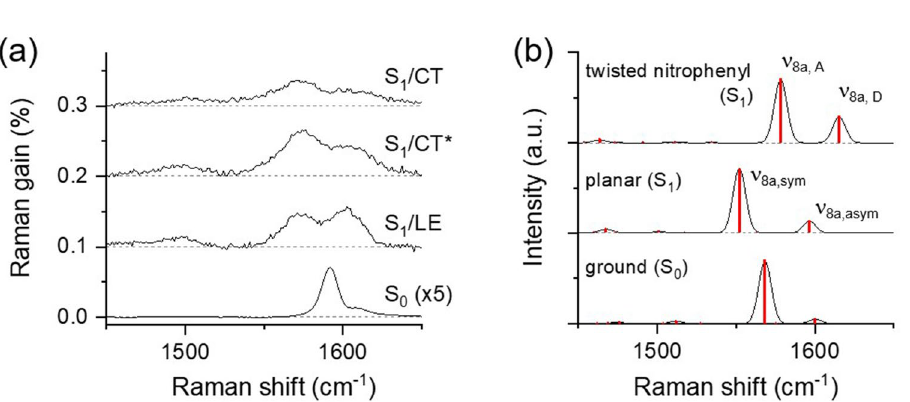
Figure 4. ( a ) Femtosecond stimulated Raman spectra of DNBP in CHCl 3 solution with 403 nm excitation. Each spectrum representing the S 1 /LE, S 1 /CT*, and S 1 /CT state was obtained at the time delays of 0.0, 0.9, and 2.9 ps. ( b ) Simulated Raman spectra of DNBP in the ground state, and the S 1 excited states with the planar and twisted nitrophenyl geometry. Approximate bandwidths of 10 cm −1 were used for the simulated Raman